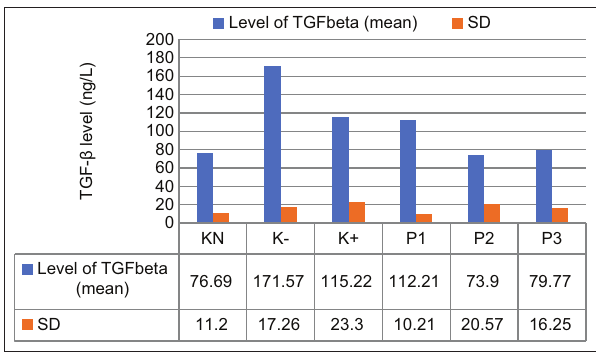
Figure-1: Effect of the ethanolic extract of red okra pods on the level of tumor growth factor- β (ng/L). KN=Normal control, K−=Negative control, K+=Positive control. P1, P2, and P3=Administrated with 50, 100, and 200 mg/kg body weight ethanolic extract of red okra pods. Each bar represents means±standard deviation (n=5). *p<0.05 compared to the negative control. **p<0.05 compared to negative and positive control